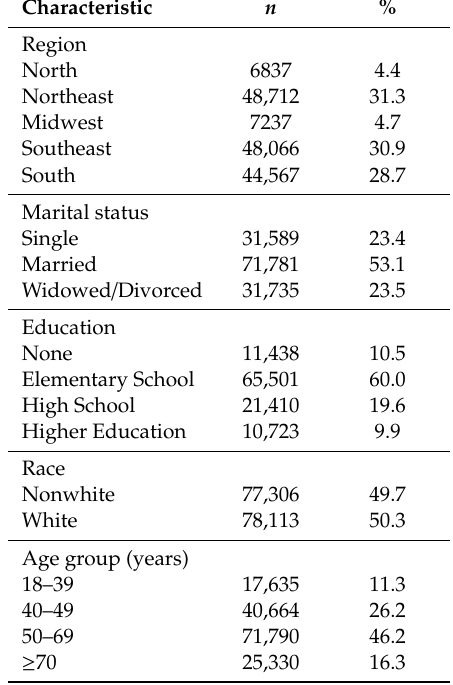
Table 2. Epidemiological characteristics of women diagnosed with breast cancer in Brazil between 1998 and